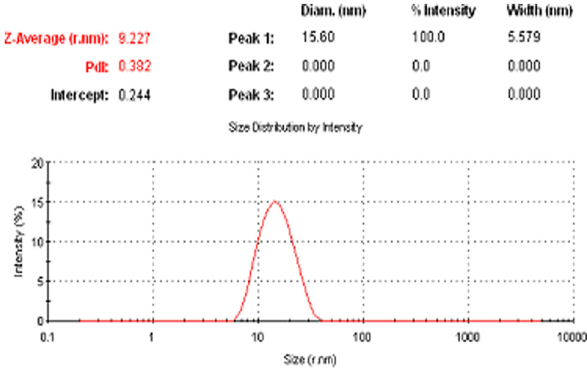
Figure 2: DLS measurement of lupin TiO 2 NPs.